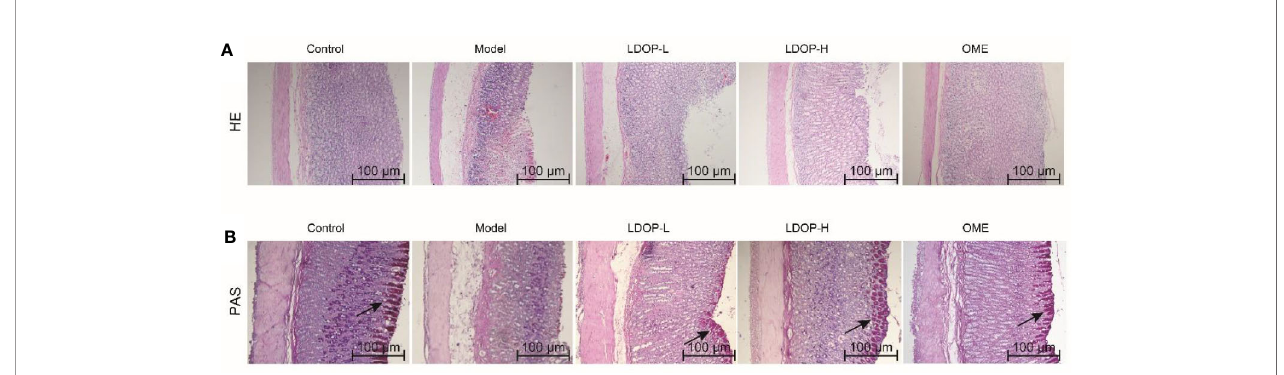
FIGURE 3 | Effects of LDOP-1 on pretreatment on the histological evaluation of ethanol-induced gastric mucosal damage in rats by H&E staining and PAS staining. H&E staining (A) and PAS staining (B) , magni fi cation (100×). LDOP-L stood for LDOP-1-L, LDOP-H stood for LDOP-1-H.